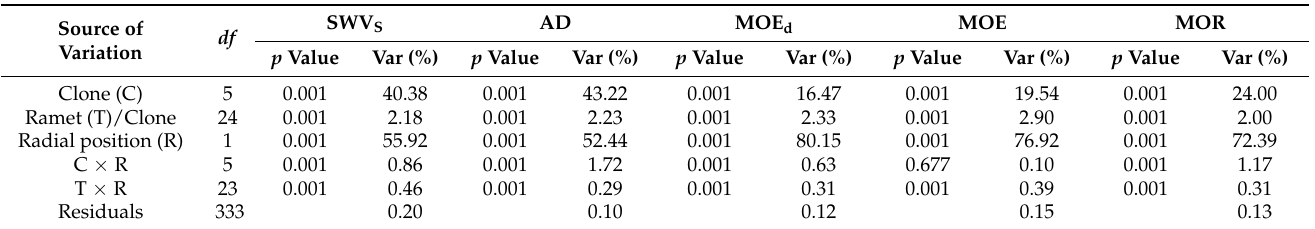
Table 5. Effects of clone, tree, and radial position on stress wave velocity, wood density, and mechanical properties of Eucalyptus